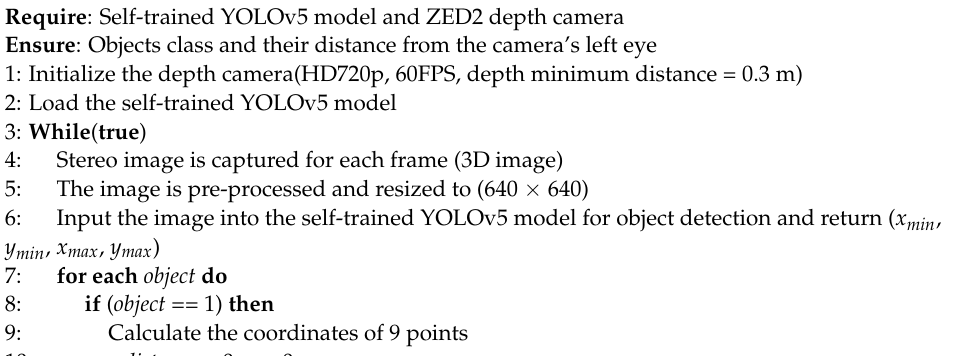
Algorithm 1 Object Detection and Distance